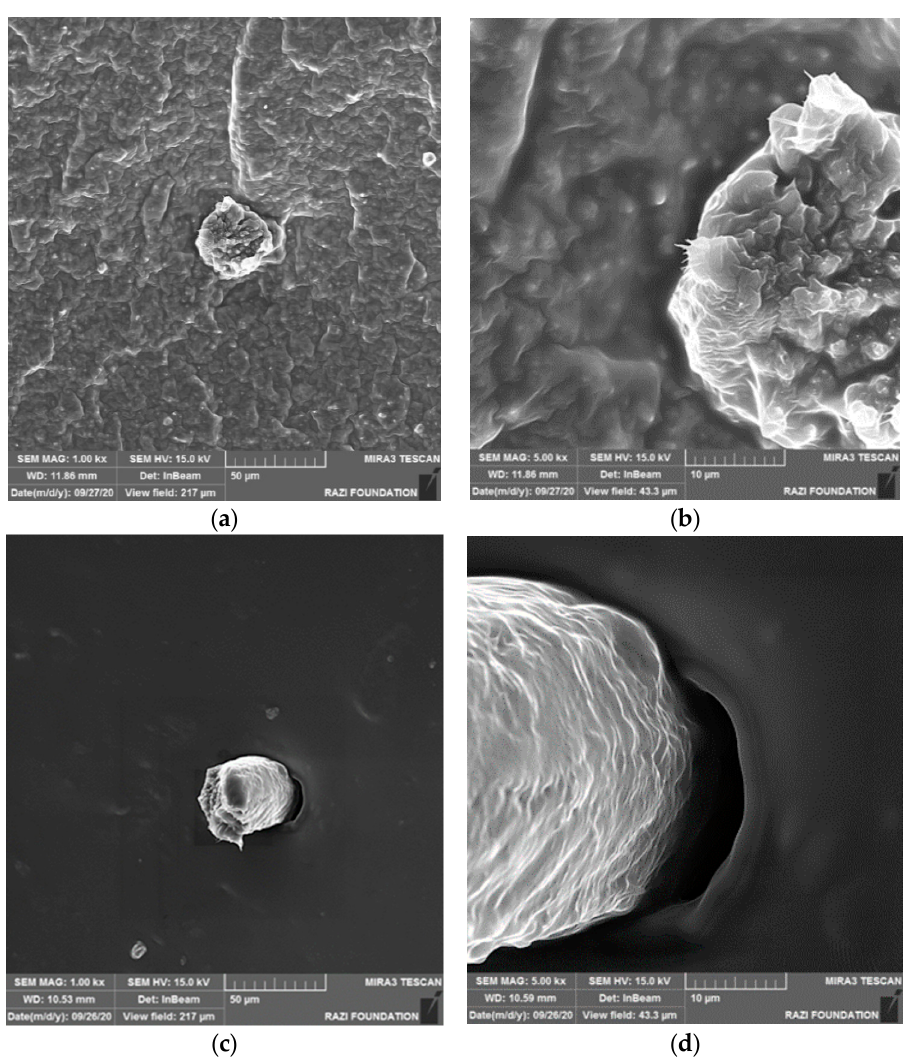
Figure 8. SEM images of the cross-section of CNTY/silicone matrix. CNTY/SR 1 at: ( a ) 1000×; ( b ) 5000×. CNTY/SR 2 at: ( c ) 1000×; ( d ) 5000×.